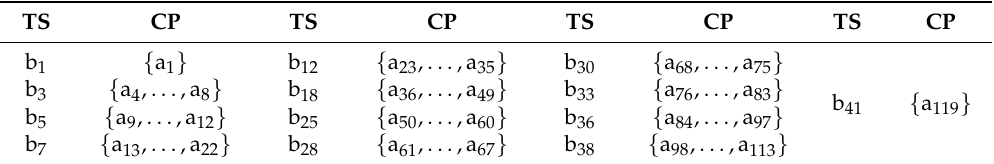
Table 1. The characteristic points in Figure 2b and the related matching candidates (TS: characteristic points; CP: candidate points).